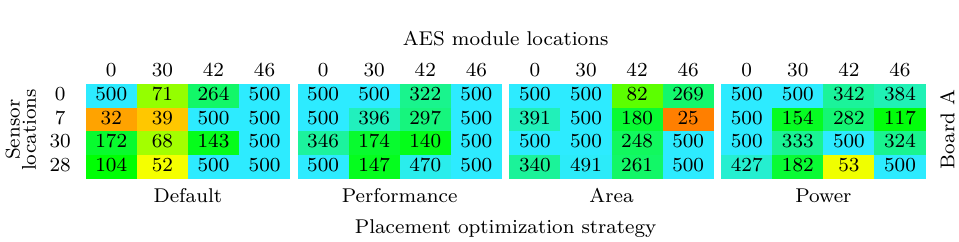
Figure 13: Minimum amount of traces ( × 1 , 000) required for a successful attack with up to 500 k traces on a design protected by our simple RO noise generator on board A. Blue cells reflect setups where up to 500 k traces are required. Here, a value of 500 k means that we were unable to recover the key with 500 k